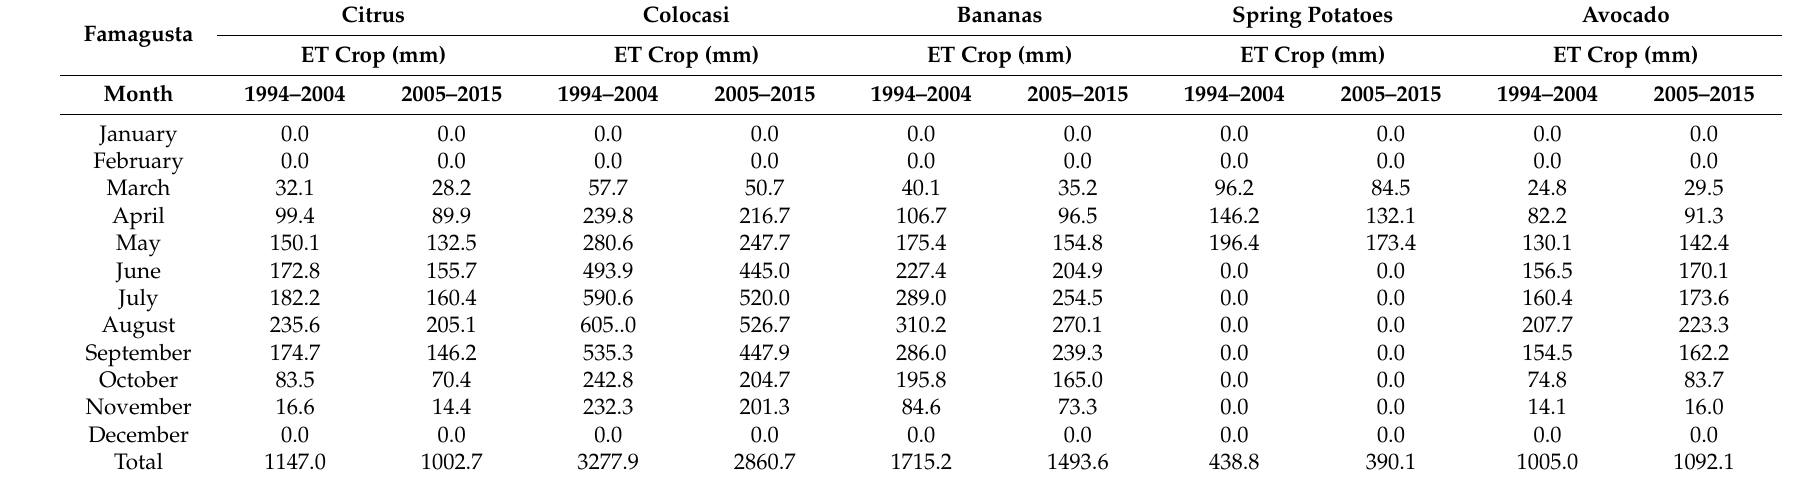
Table 4. Average monthly ETc values for each crop for the Famagusta